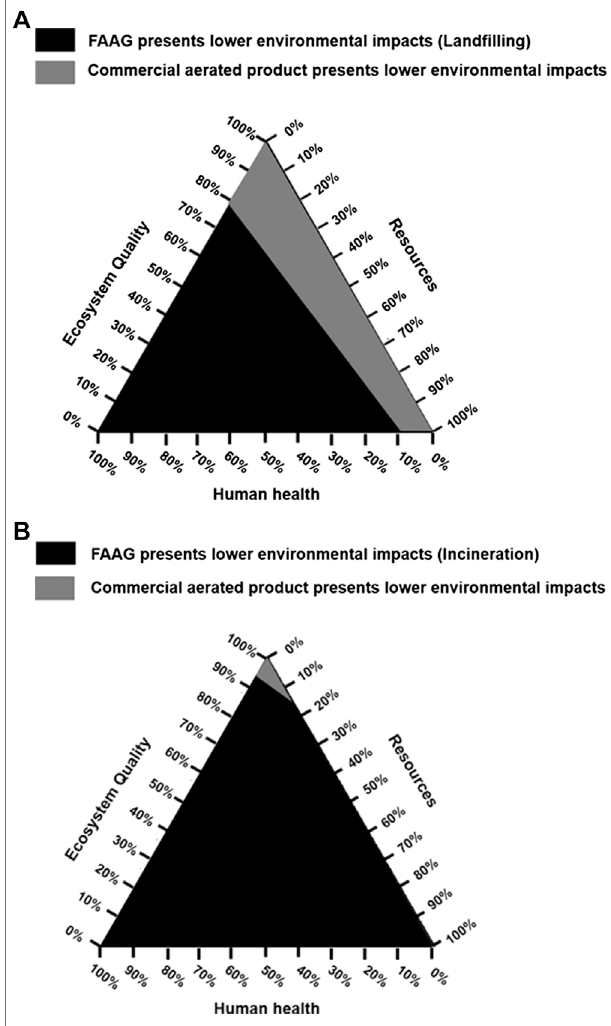
FIGURE 13 | A comparison between damage categories of preparation of 1 kg foamed alkali-activated glass (FAAG) considering impacts of waste glass (A) land fi lling; (B) incineration and 1 kg commercial aerated products on a mixing triangle.